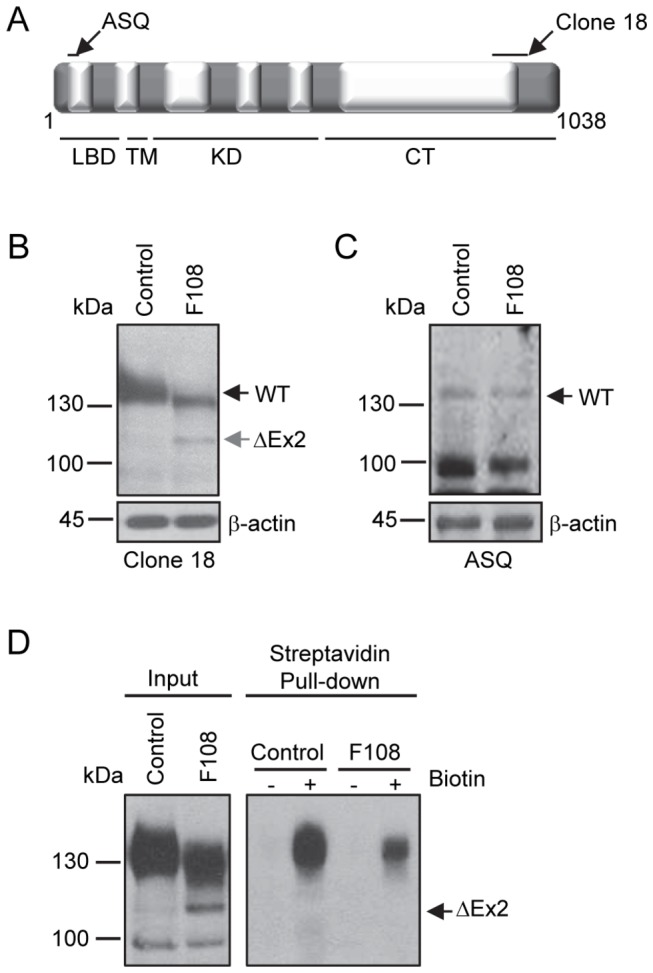
HPAH patient-derived lymphocytes express mutant BMPR2 products.A, Schematic of the BMPR2 protein. Areas recognized by the anti-BMPR2 antibodies clone 18 and ASQ are indicated by black arrows. Exons 1-13 are represented by alternating gray and white boxes, and numbers indicate corresponding amino acids. LBD, represents the ligand binding domain, TM the transmembrane domain, KD the kinase domain and CT the cytoplasmic tail. B, Detection of BMPR2 products in HPAH patient-derived lymphocytes, image representative of three experiments. Western blot using anti-BMPR2 antibody, Clone 18. A 130-145 kDa wild type BMPR2 product (WT) was detected in normal control and Family 108 (F108) HPAH patient-derived lymphoblasts. F108 cells expressed an additional 120 kDa BMPR2 mutant product (ΔEx2). C, Representative western blot from three experiments using the ASQ anti-BMPR2 antibody. The 130-145 kDa product was detected in both control and F108 lymphocytes, but the 120 kDa band was not detected. D, Cell surface expression of BMPR2 in HPAH patient-derived lymphocytes labeled with a membrane impermeable biotin. Experiment replicated three times. Left panel, input cell lysates before the streptavidin pull-down. Right panel, cell surface proteins detected in streptavidin pull-down by Western blot using Clone 18 anti-BMPR2 antibody. A 130-145 kDa wild type BMPR2 product was detected in control and F108 cultured lymphocytes in streptavidin pull-down but not 120kDa BMPR2ΔEx2 mutant product.